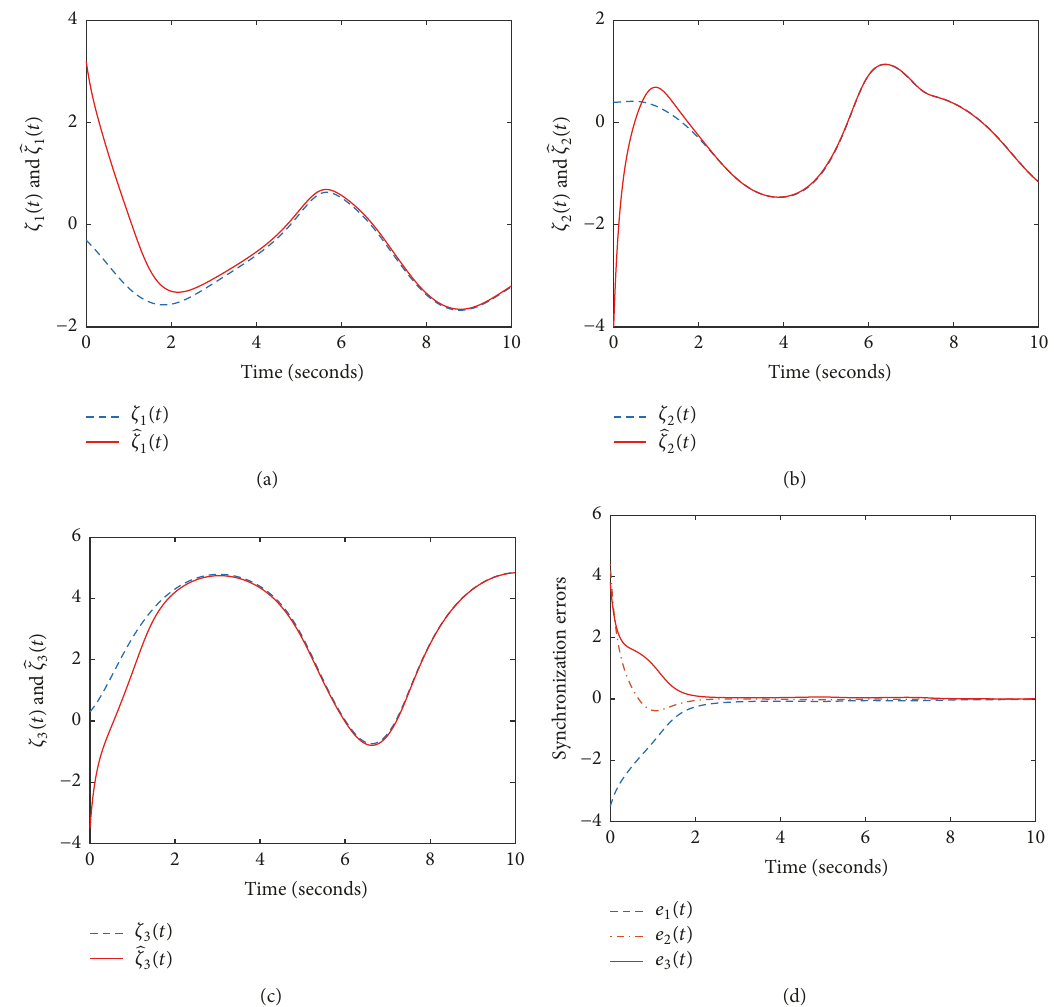
̂𝜁 (𝑡) , (b) synchronization between 𝜁 1 (𝑡) , 𝑒 (𝑡) , and 𝑒 (𝑡) . 1 2 3